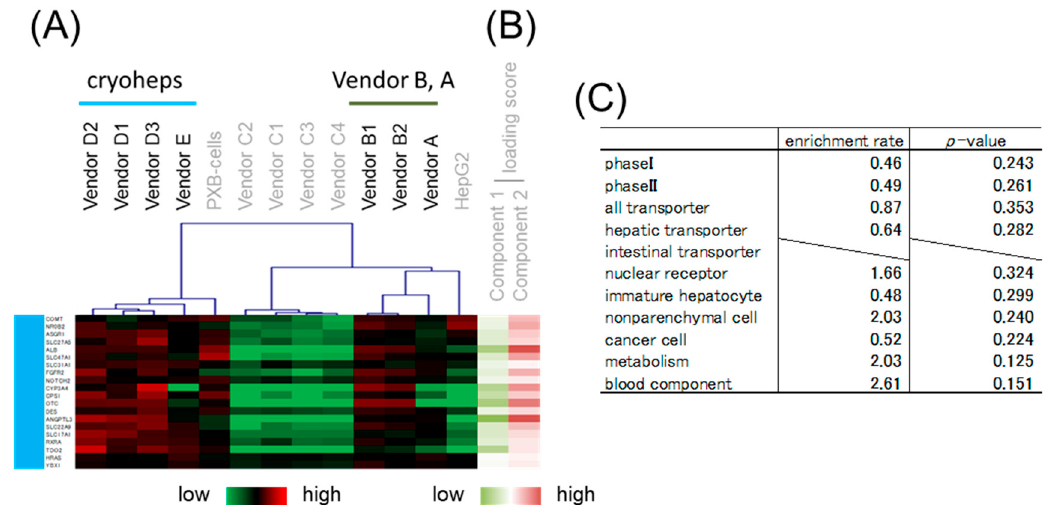
Figure 9. Enrichment analysis of the blue branch. ( A ) Heatmap patterns. ( B ) PC 1 and 2 scores. Red lines exhibit plus scores, and green lines exhibit minus scores. ( C ) Enrichment rates and p -values from the chi-squared test of different gene categories.